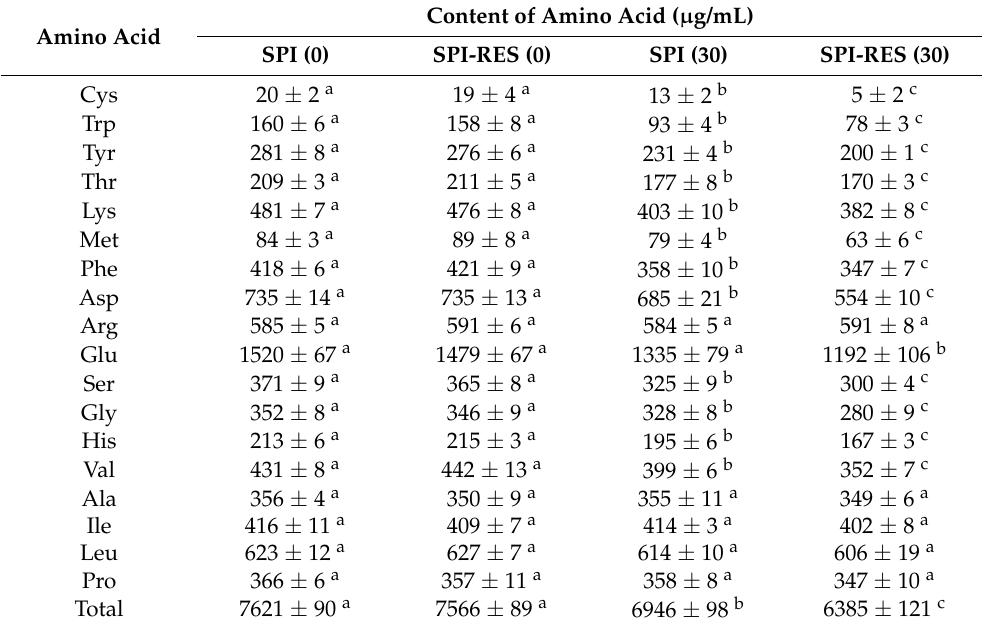
Note: Different lower-case letters in the same row represent significantly different mean values ( p < 0.05).